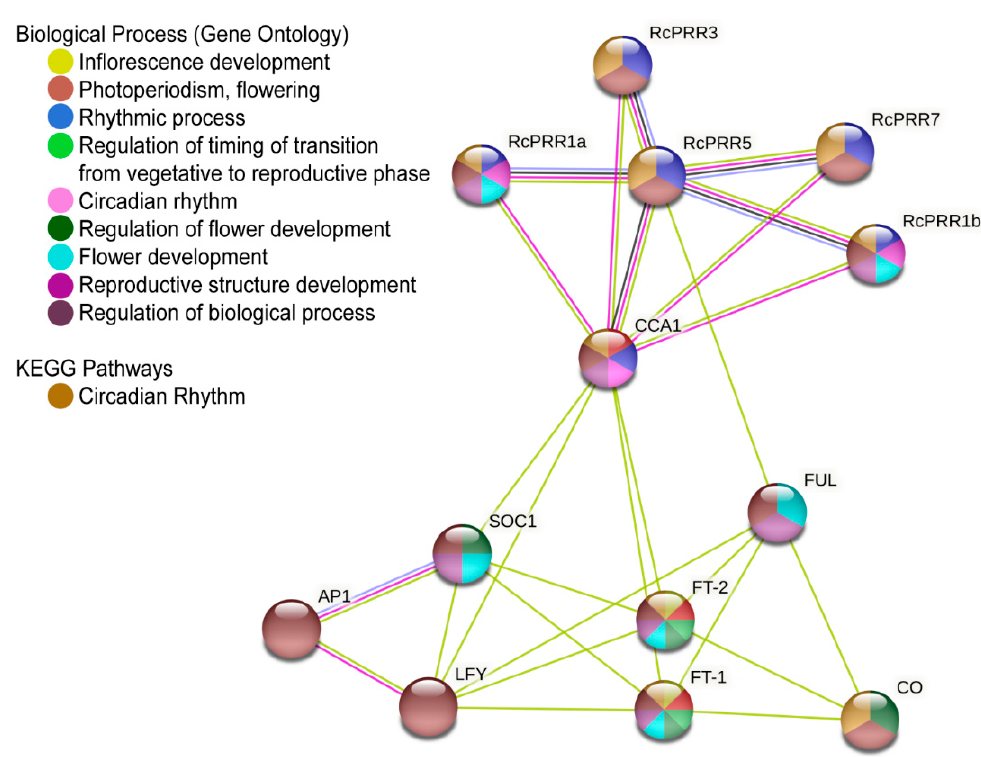
Figure 7. Co-expression network and functional annotation of clock PRRs genes with other flowering pathways genes in Rosa chinensis. Different colors of nodes represent genes sharing biological processes, while the edges/lines connecting the nodes represent the protein-to-protein interaction between genes. The addition of edges/lines between two nodes signifies a more significant interaction.